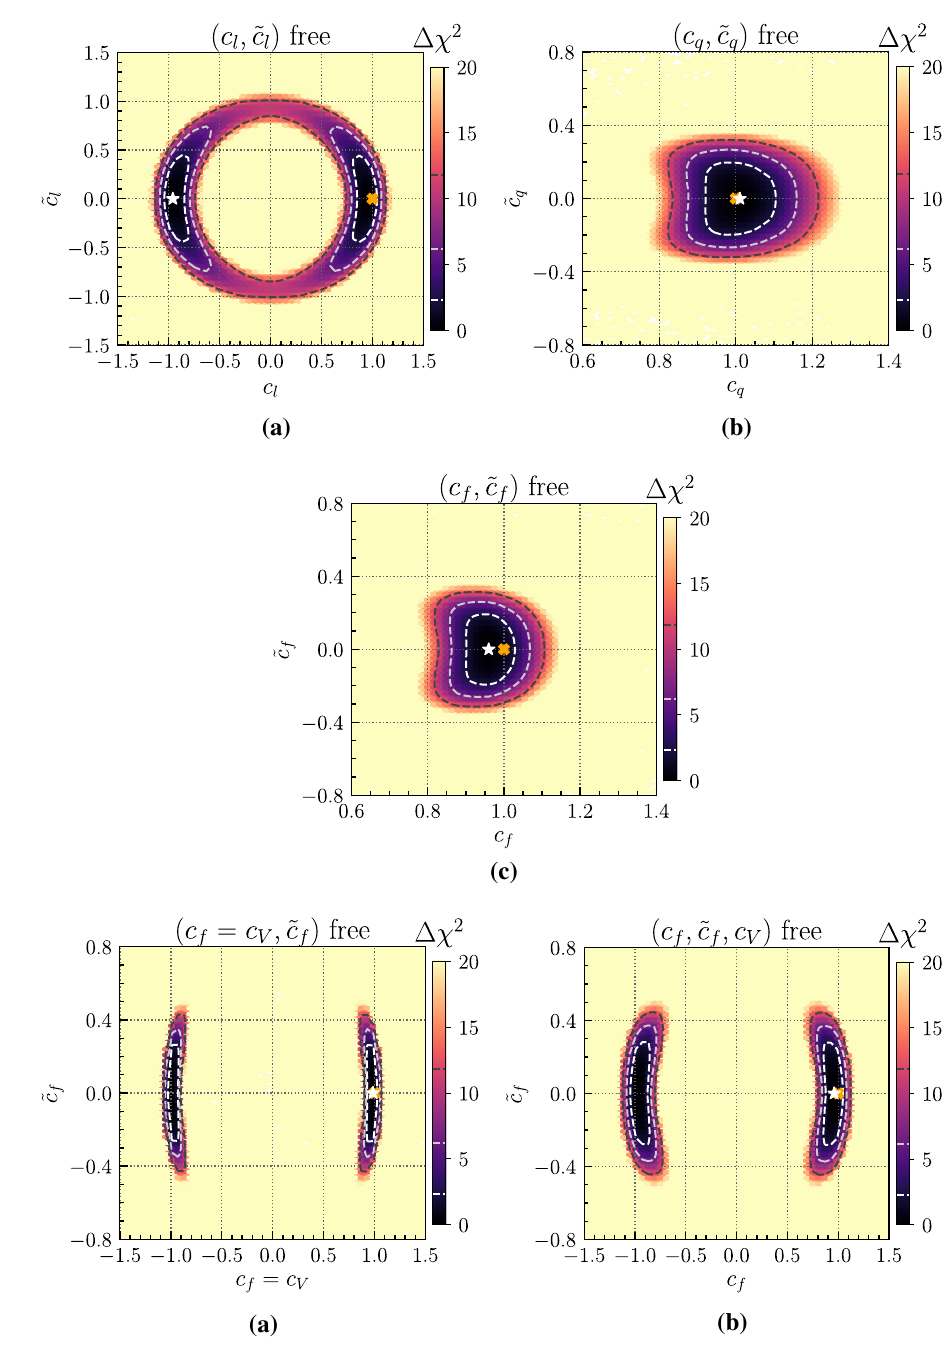
Fig. 7 Universal, fermion+V models: results of fits to the LHC measurements in the ( c f , ˜ c f ) parameter plane with a c f = c V and b c V free-floating. In each case, the CP -even and CP -odd parts of the couplings shown in the plot are free-floating while all the other parameters are set to their SM values. The legend corresponds to the one in Fig.